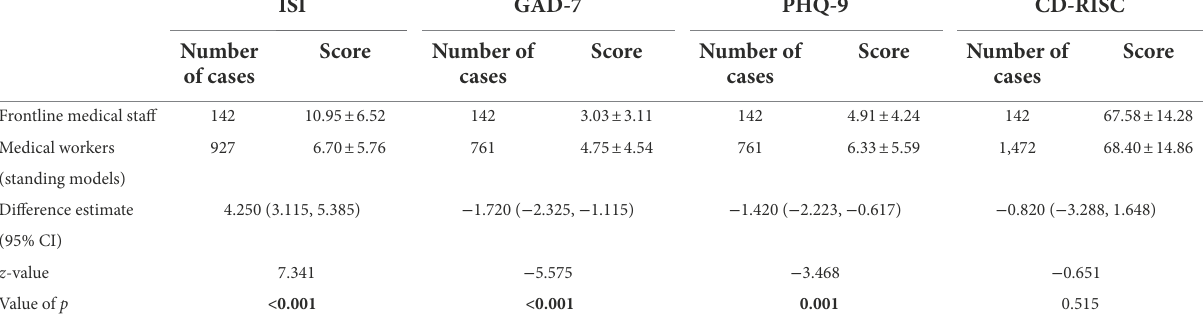
TABLE 8 Comparison of frontline medical staff and control group.